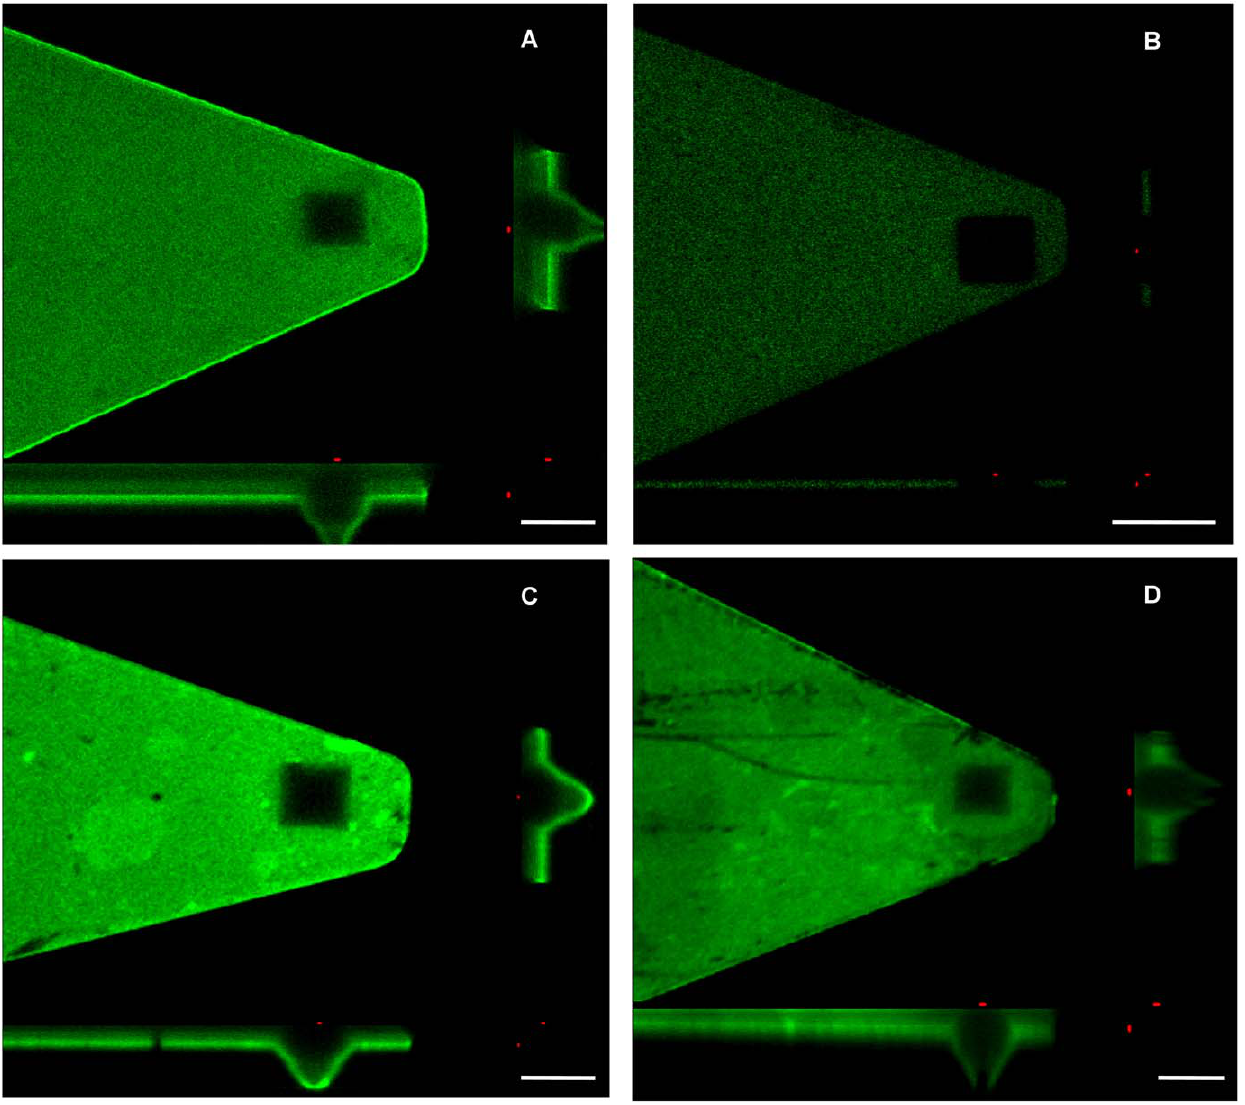
Figure 2. Three dimensional confocal images of functionalized AFM tips stained with antibody conjugated with fluorescent dyes. (A) Freshly prepared AFM tip with TSP conjugated. (B) Unmodified AFM tip as a control. (C) Used but still functional tip. (D) Used and ‘dead’ tip. Images were taken using Nikon N1 confocal microscope equipped with a 100X oil immersion objective. Scale bars represent 5 m m.